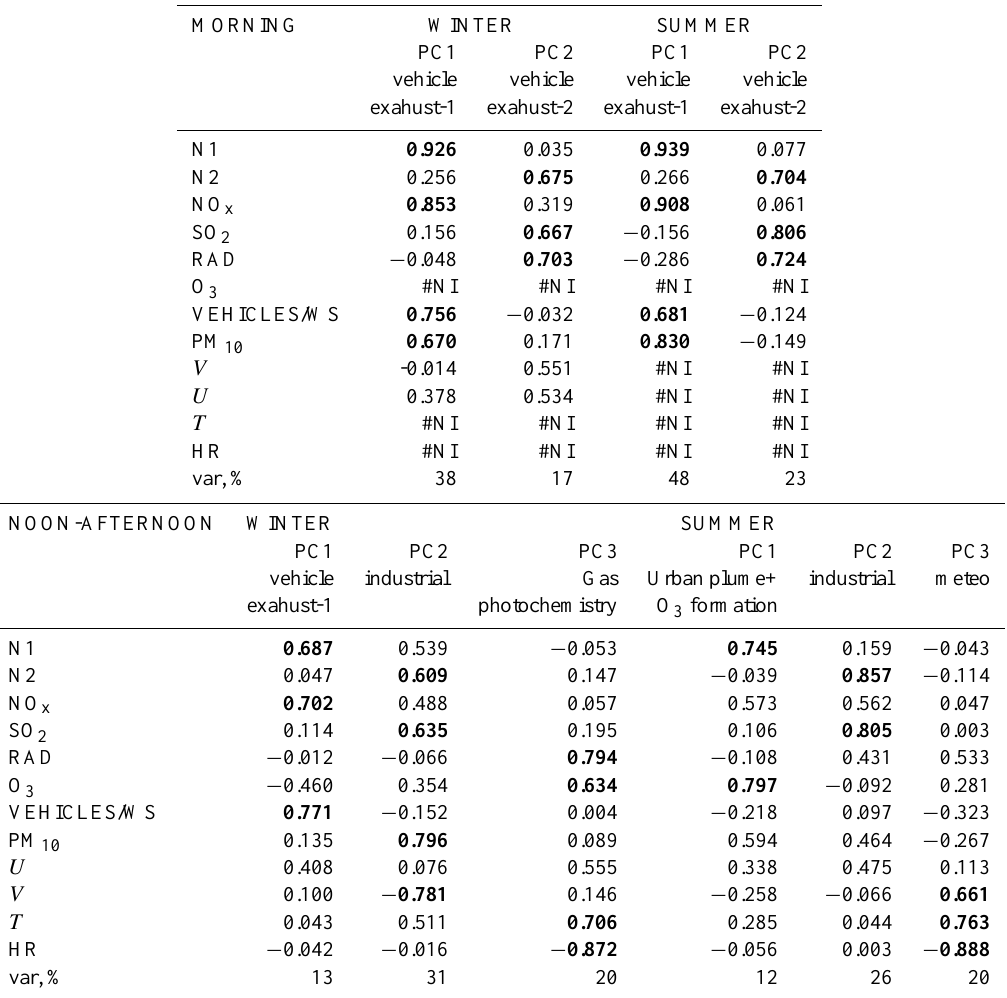
Table 2. Factor loading of the Principal Components Analysis (followed by a varimax rotation) obtained with hourly data in the morning (06:00–09:00h) and noon-afternoon (11:00–17:00h) in summer (June–September 2008) and winter periods (January–March 2009). Factor loadings with absolute values ≥ 0.6 are in bold. RAD: Solar radiation; VEHICLES/WS: Number of vehicles/hour; U : zonal component of wind (west–east); V : meridional component of wind (south-nort). #NI: variable non included in this